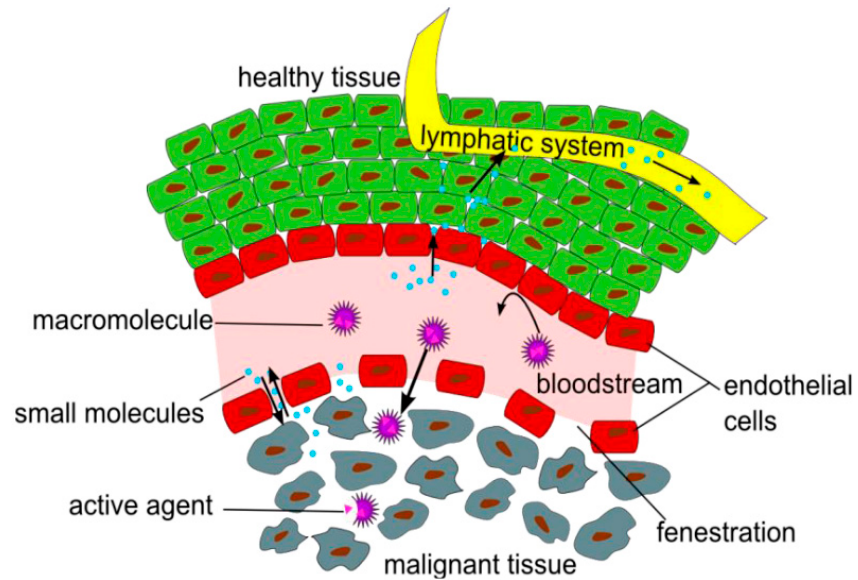
Figure 4. Schematic representation of the EPR effect. Reproduced with permission from [87] (published by MDPI), licensed under CC BY 3.0.